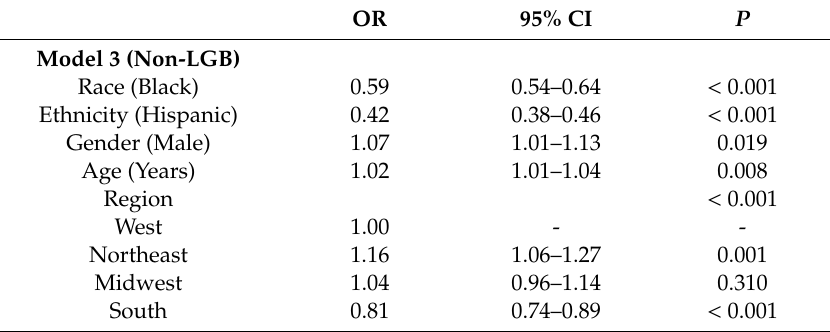
Table 4. Logistic regression models on current smoking by sexual